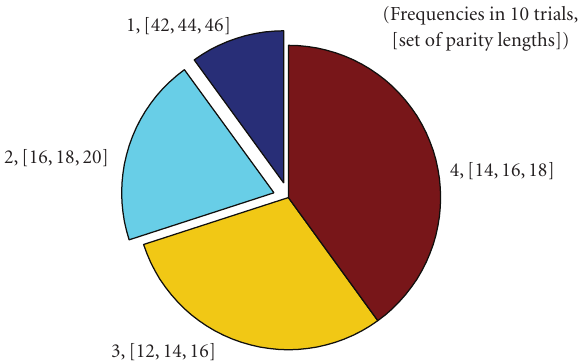
Figure 7: Average distribution (frequency) of the set of parity lengths in 10 trials for BER = 0.003.